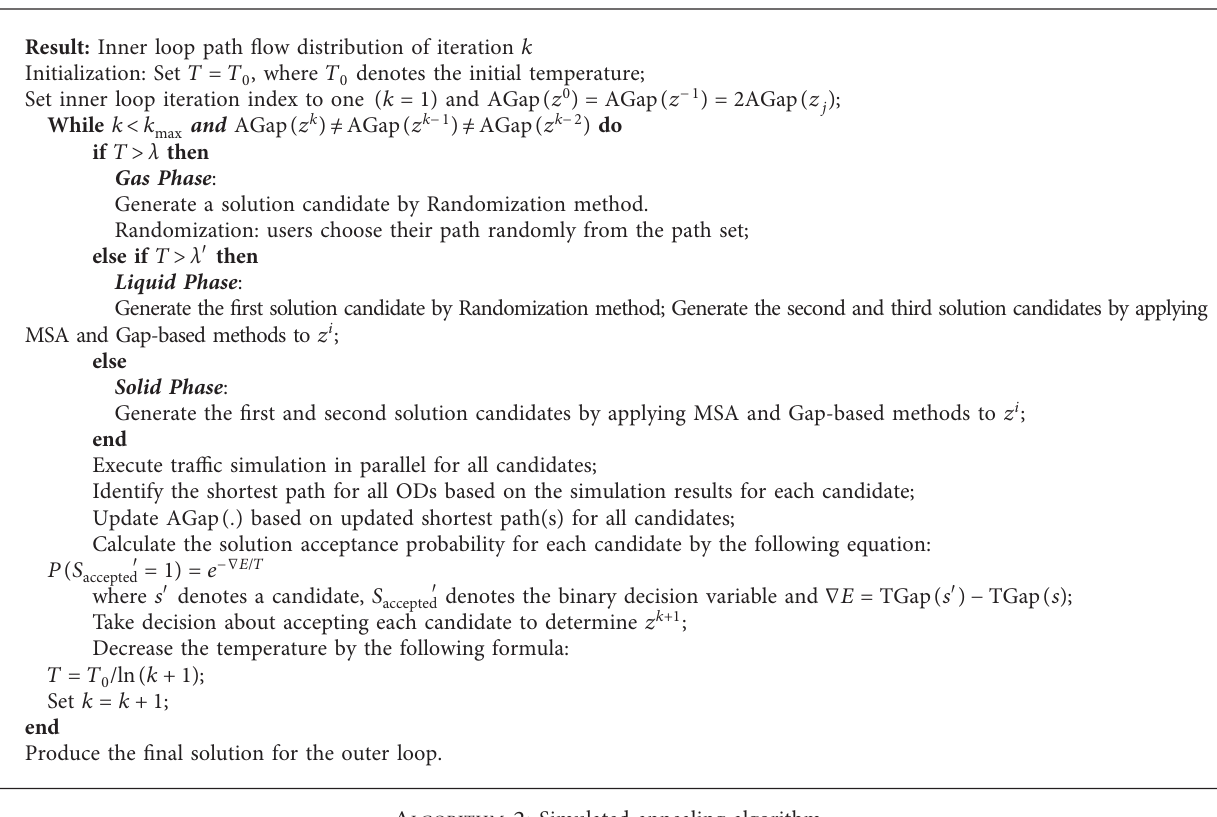
A LGORITHM 2: Simulated annealing algorithm.